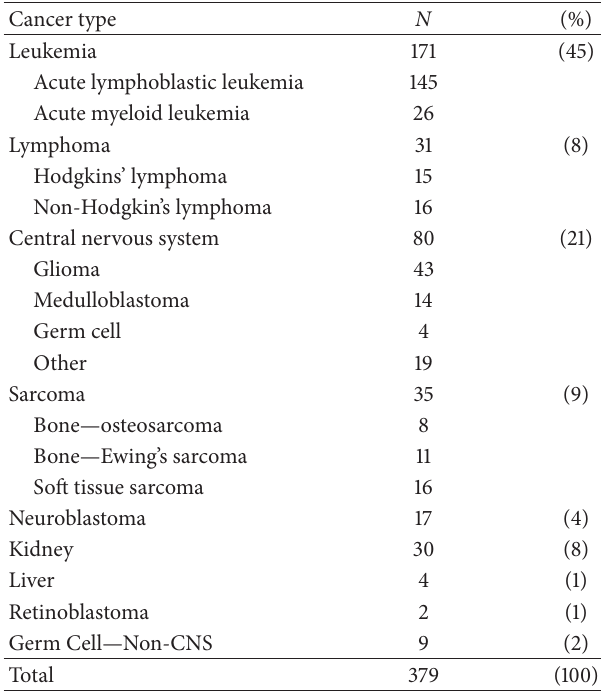
Table 1: The distribution of childhood cancers enrolled in the Victorian Paediatric Cancer Family